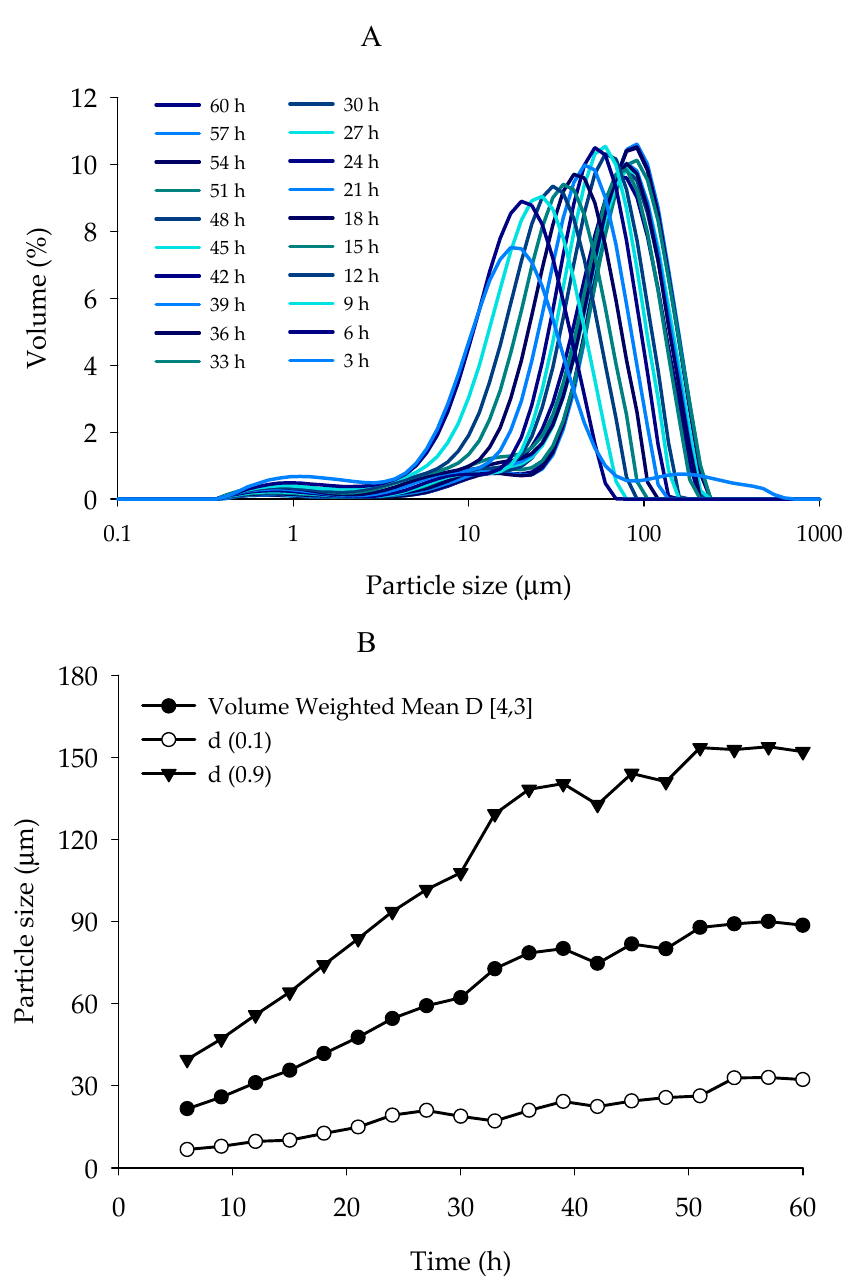
Figure 2. Variation of particle size according to: ( A ) elapsed time in preliminary experiment, and ( B ) average, upper, and bottom 10%.